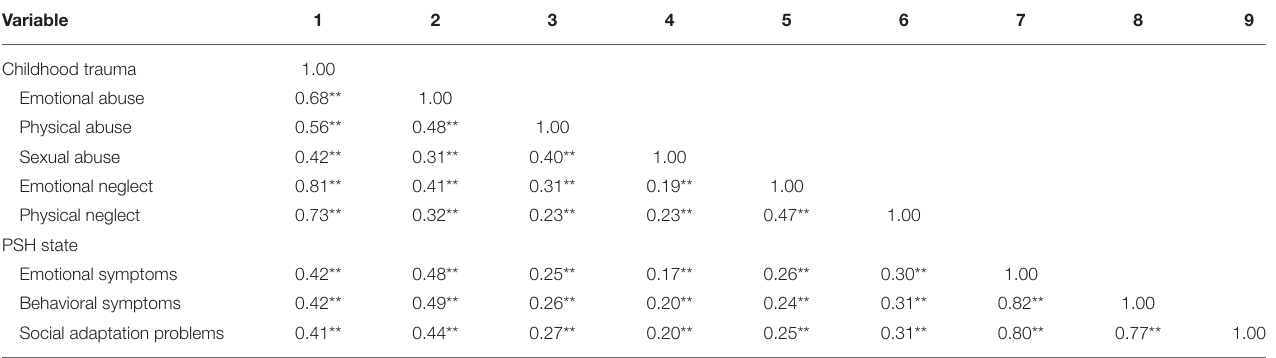
TABLE 3 | Associations between childhood trauma and psychological sub-health state ( n = 778). Variable